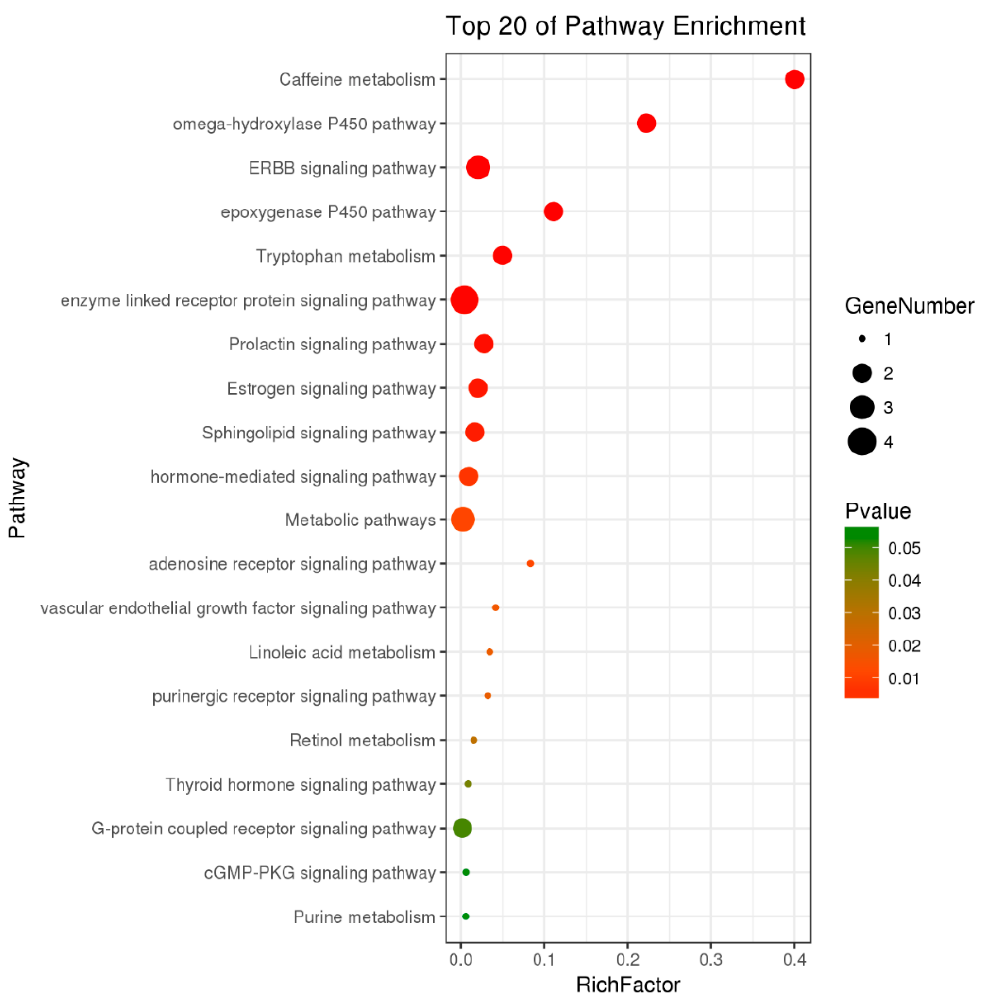
Figure 7. Biological process for merge gene.